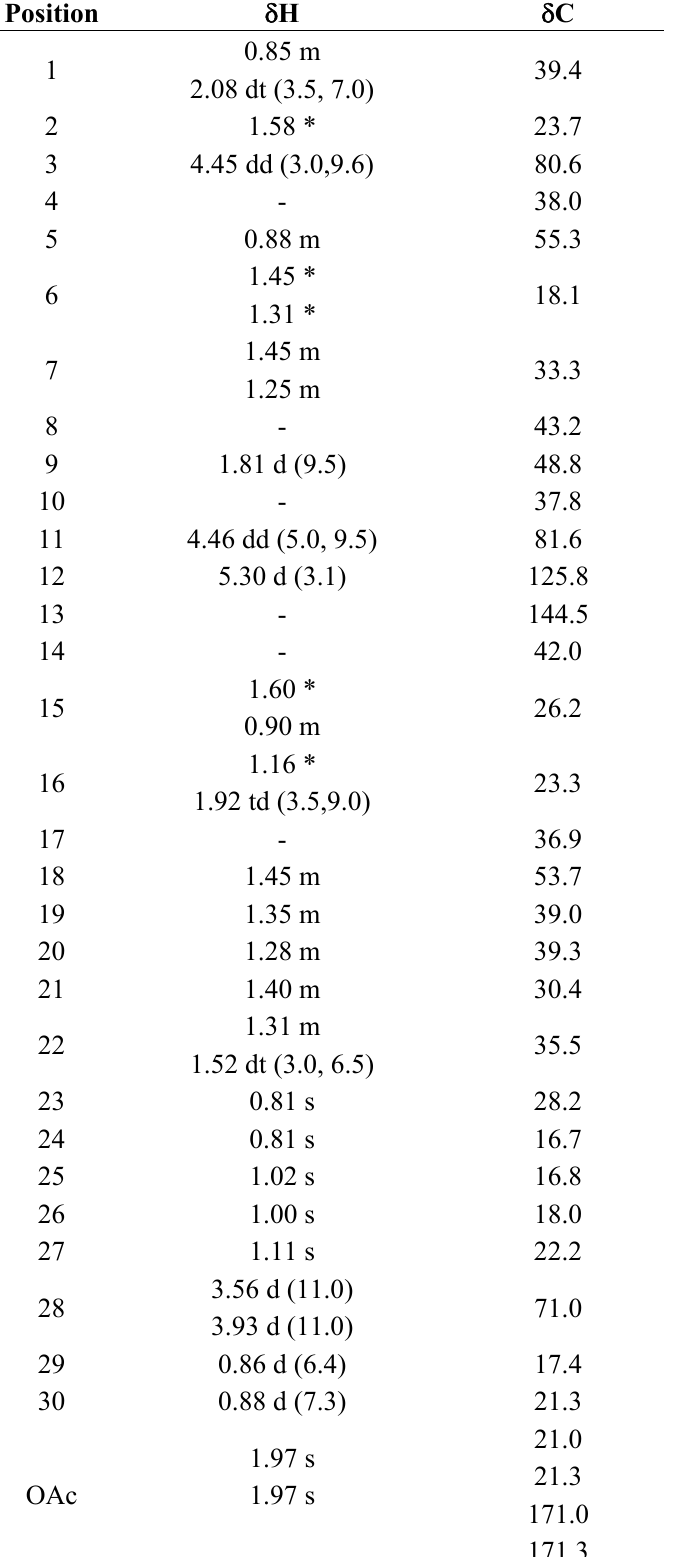
Table 2. 1 H and 13 C-NMR data for compound 3a a